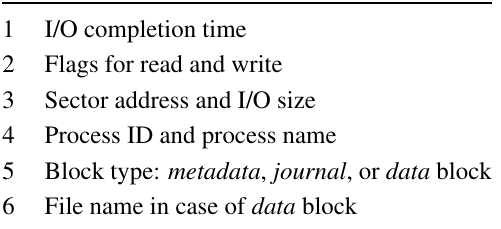
Table 2. Output of Mobile Storage Analyzer.